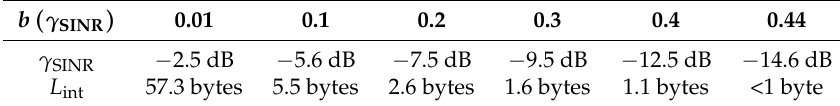
Table B1. Conditions making K L int < 0.01 for IEEE 802.15.4